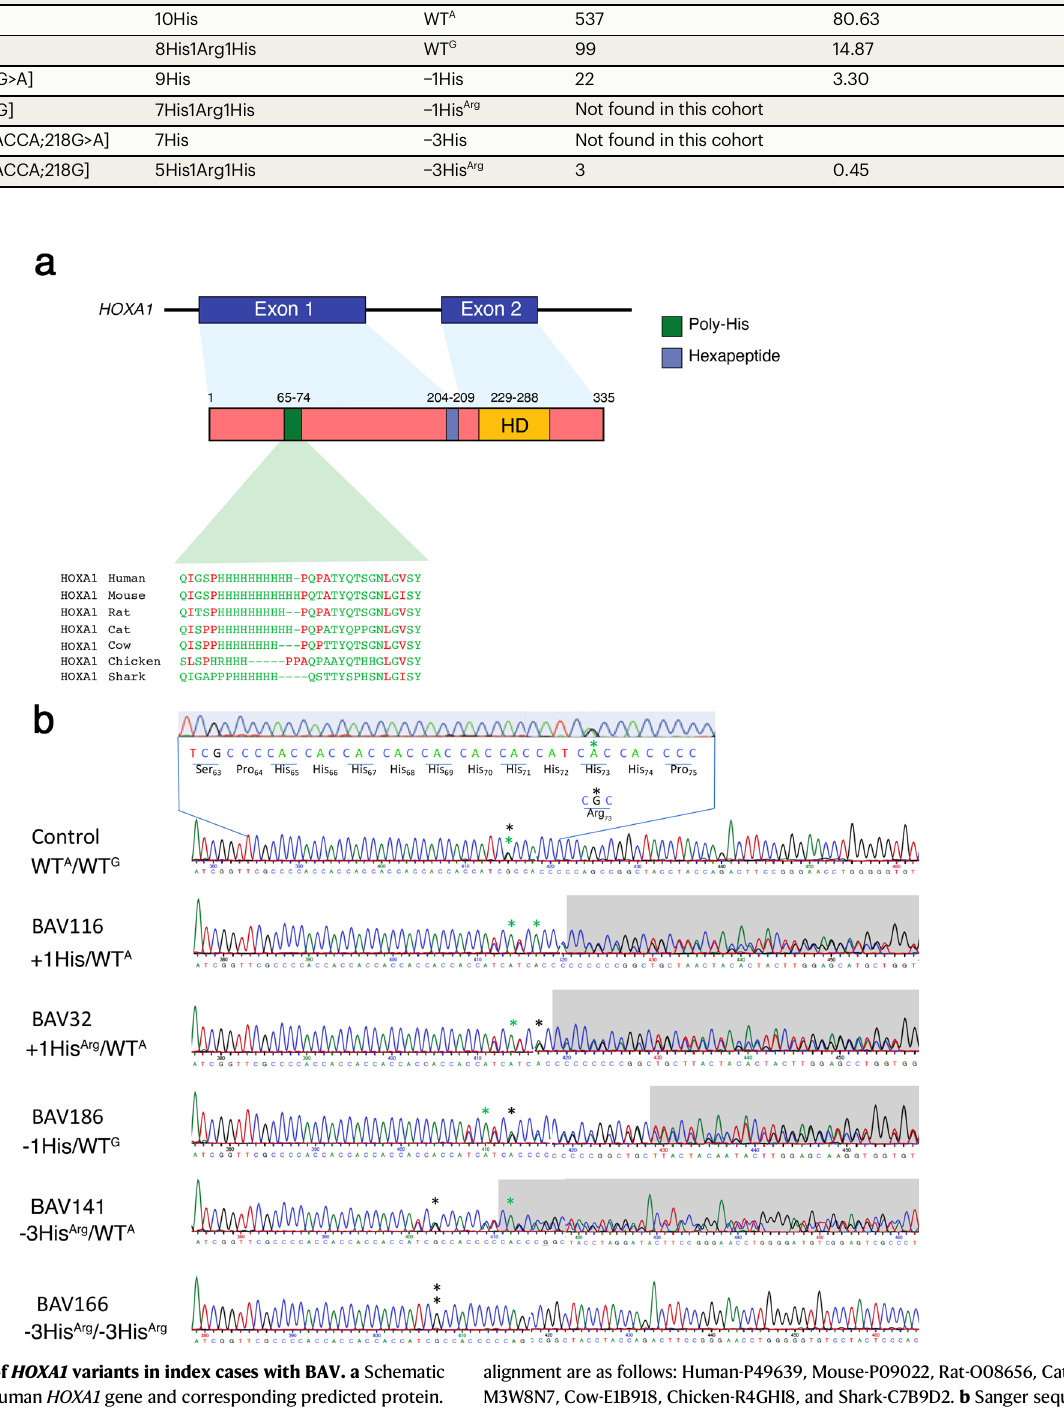
alignment are as follows: Human-P49639, Mouse-P09022, Rat-O08656, Cat- M3W8N7, Cow-E1B918, Chicken-R4GHI8, and Shark-C7B9D2. b Sanger sequences showing the insertion or deletion variants observed in exon 1 of HOXA1 . The